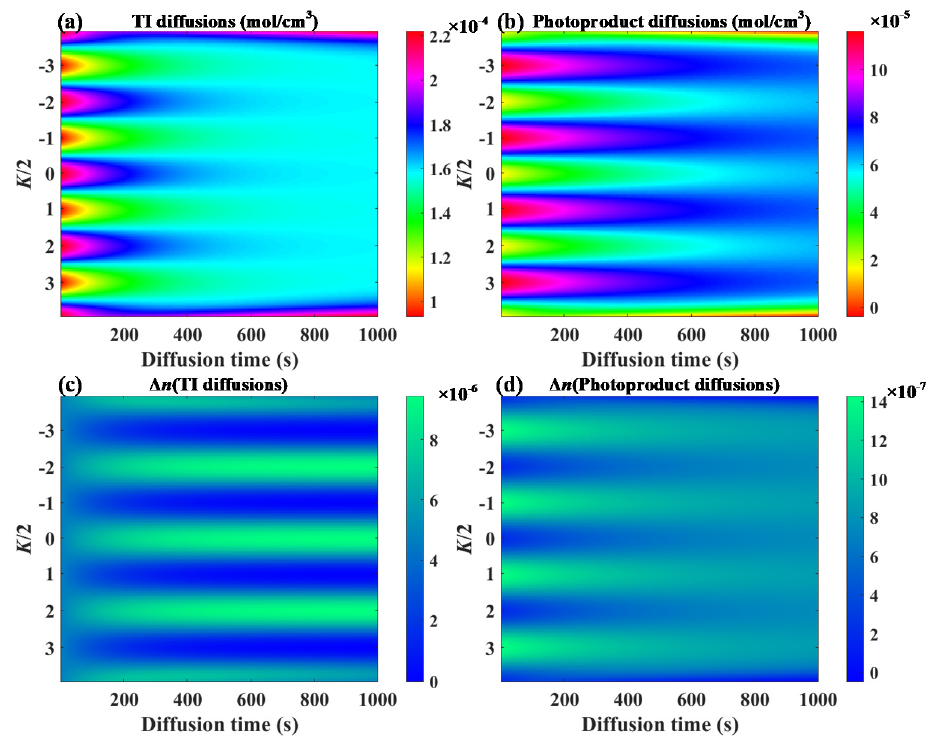
Figure 3. Theoretical model of DDEP: ( a ) TI diffusion distributions, ( b ) photoproduct diffusion distributions, ( c ) refractive index modulation of TI diffusion, ( d ) refractive index modulation of photoproduct diffusion.